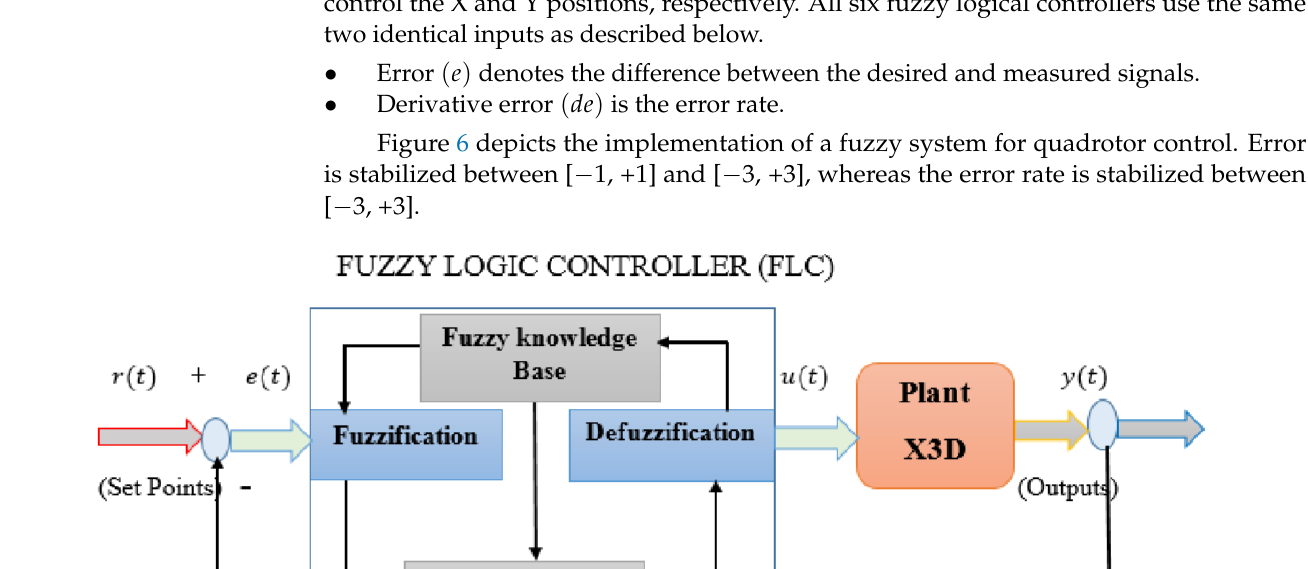
Table 4. X3D Quadrotor’s Fuzzy